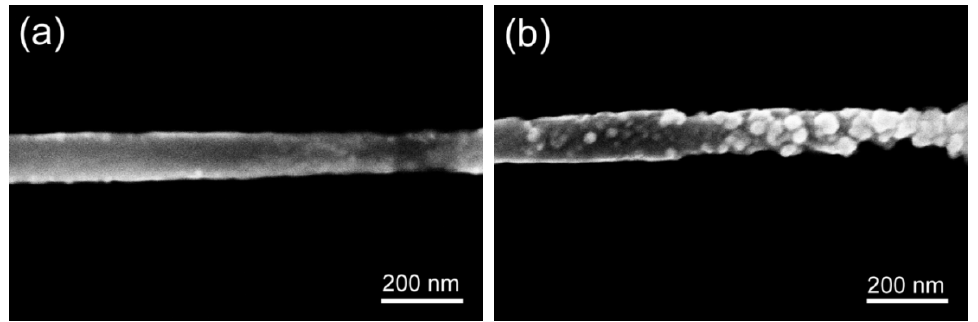
Figure 2. Scanning electron microscopy (SEM) images of single PANI nanowires. ( a ) before the surface functionalization and ( b ) after the surface functionalization with cTnI mAbs. The two SEM images were taken at the same location of the